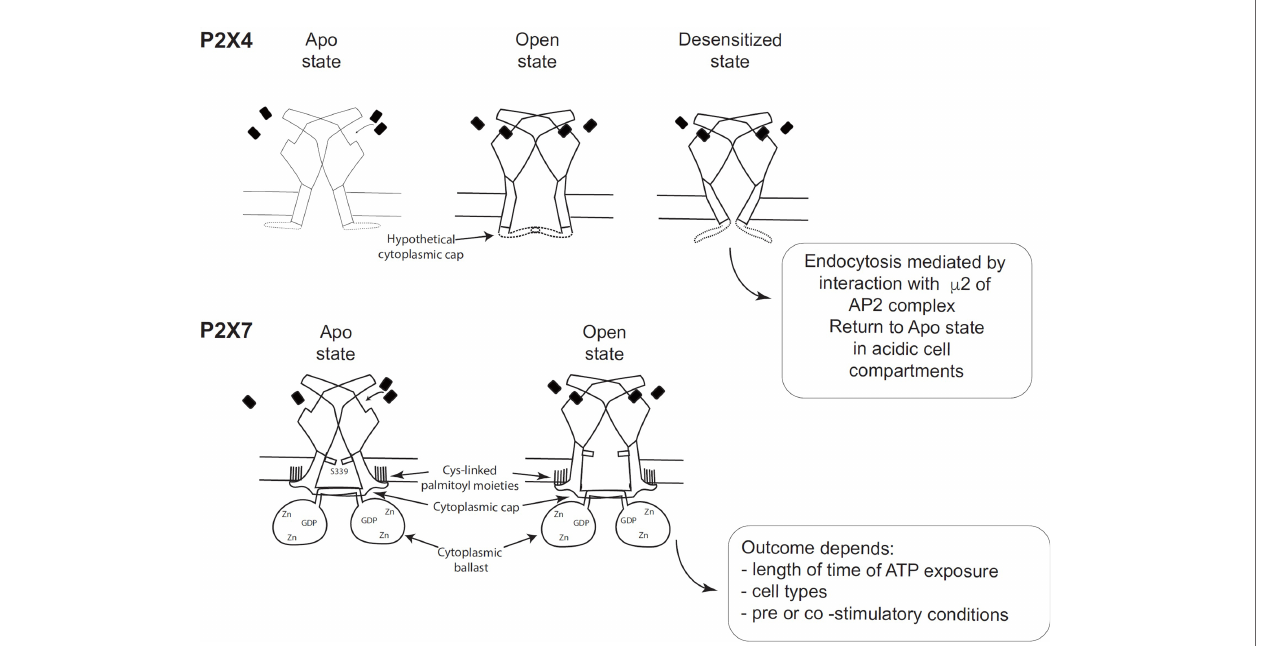
FIGURE 2 | Schematic comparison of the desensitizing P2X4 receptor with the non-desensitizing P2X7 receptor (adapted from Figure 7 of McCarthy et al. (11). (Top panel) Hypothetical schematic fi gure of the P2X4 receptor in Apo state, Open state and Desensitized state. (Bottom panel) P2X7 receptor in Apo state and Open state. Black rectangles symbolize ATP molecules. As shown by McCarthy et al., the lack of desensitization of P2X7 is due to the stability of the cytoplasmic cap and to the palmitoylated residues of the C-cysteine anchors, which should stabilize the cytoplasmic cap and maintain TM2 in an open con fi guration